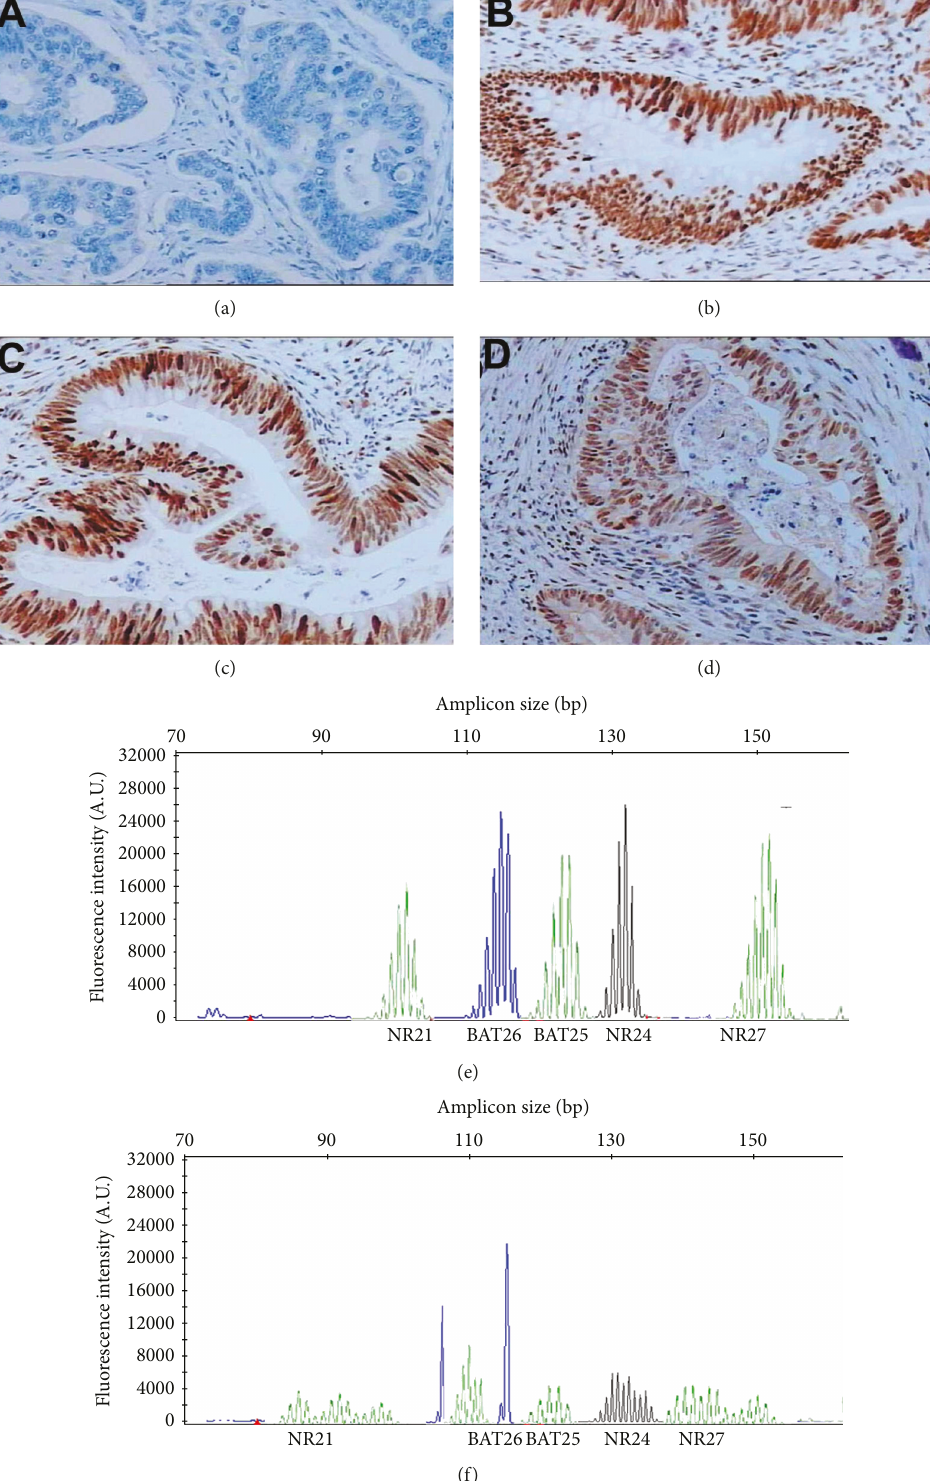
Figure 2: MMR protein determination and MSI status analysis. Immunohistochemical staining pattern of MSI-L colorectal carcinoma samples with isolated loss of MLH1 (a) and intact staining of MSH2 (b), MSH6 (c), and PMS2 (d); examples of fl uorescence-based PCR of mononucleotide repeats and typical pro fi les of a MSS tumor (e) and a MSI-H case (f). MMR: mismatch repair; MSI: microsatellite instability; MSI-L: MSI-low; MSI-H: MSI-high; MSS: microsatellite stability; PCR: polymerase chain